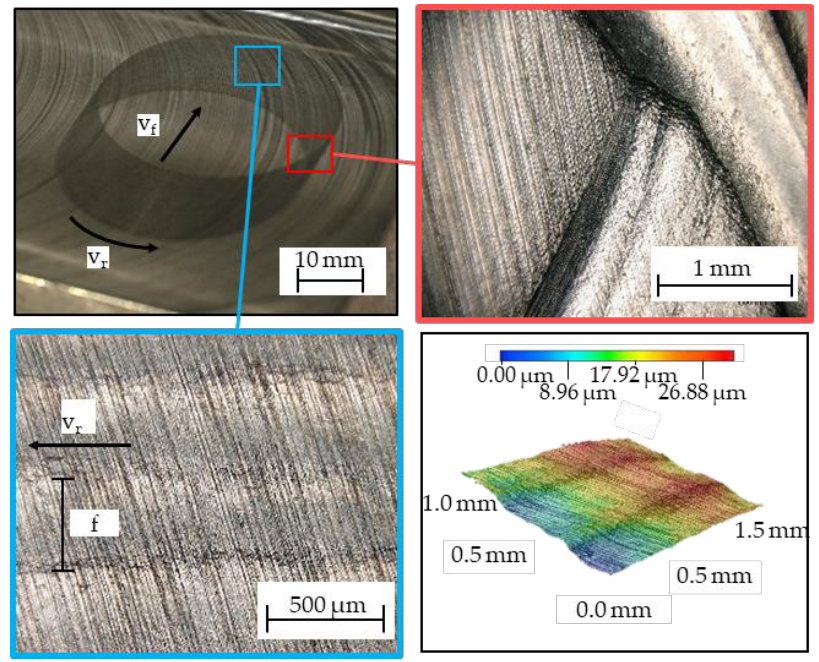
Figure 16. Surface geometry of a pulse rolled area resulting for S = 100 (s/min) and fpr = 25 (mm/min).